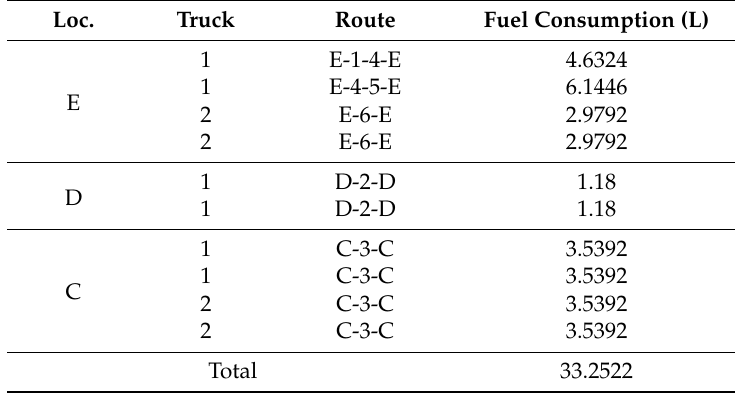
Table 10. The fuel consumption of all